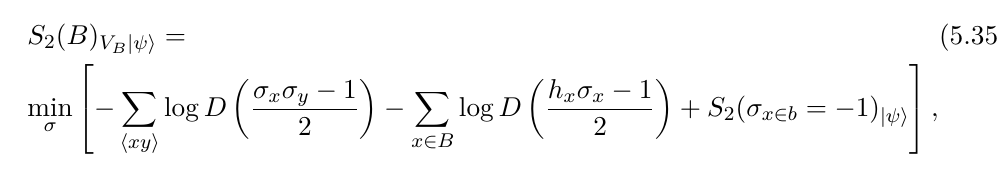
is the bulk geodesic B